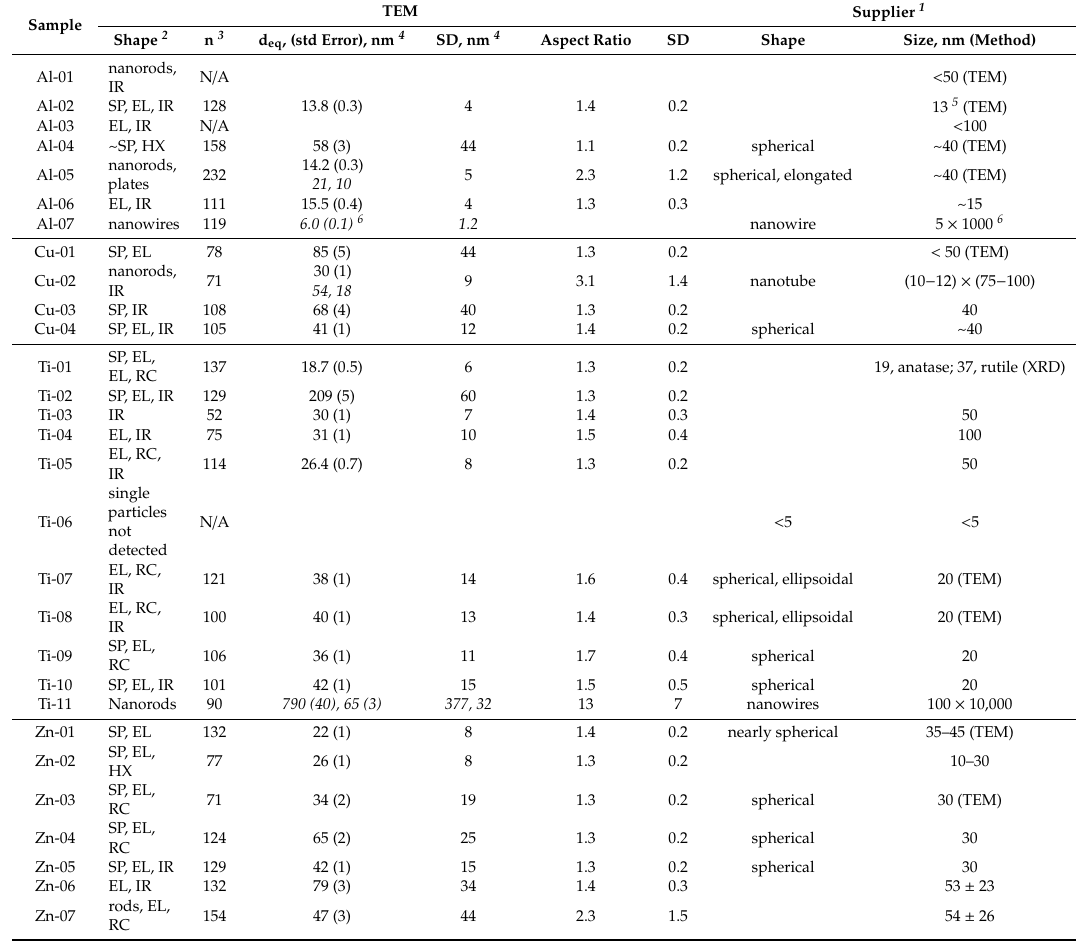
Table 3. Comparison of particle shape, particle size distribution (equivalent diameter, d eq and aspect ratio) as determined experimentally by TEM with shape and size data provided by the